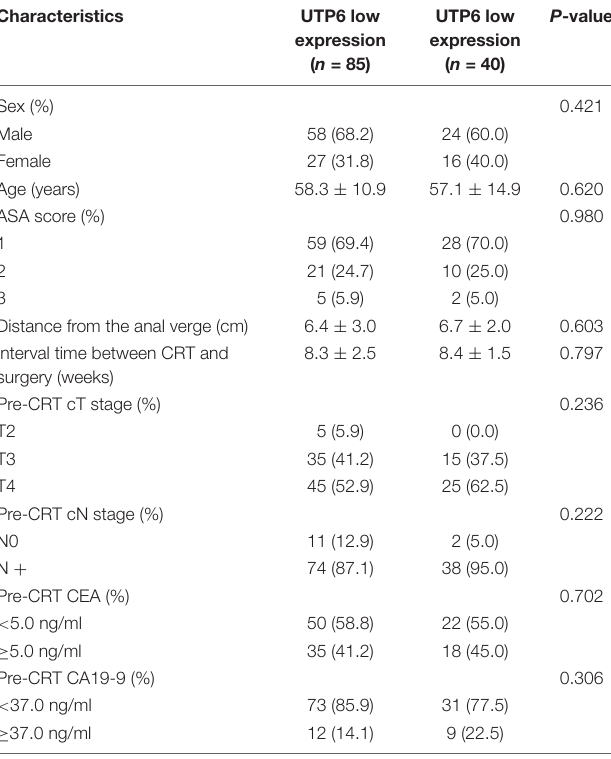
TABLE 5 | Operative and postoperative outcomes in patients with LARC following CRT stratified by UTP6 expression ( n = 125).